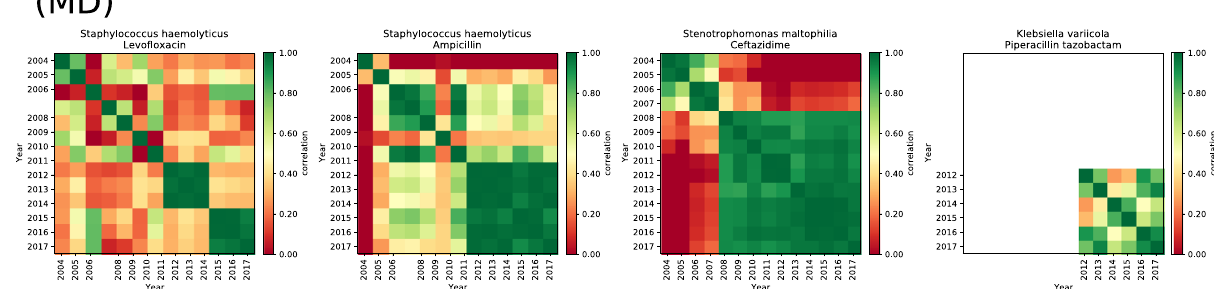
Fig. 3 Four of the “ worst ” pathogen-antibiotic (PA) pair year-year correlations ranked by τ (as de fi ned in Supplementary §5): these satisfy τ < 1/4. PA pairs typically have low values of τ because their correlelograms exhibit block structures consistent with high year-year correlations between MIC distributions that incorporate sudden changes. The particular MIC correlations shown here are for PA pairs that satisfy τ < 1/4 that are also classi fi ed as both D and M, as described in the text. An M label refers to a PA pair where sampling was very low in one particular year and pairs with high sampling variability across years are labelled with a V. Not shown here are other PA pairs with low sampling size across years (labelled as N) and ones where the discrepancy between TEST and INFORM MICs is high (labelled as D). Pairs that do not fall under any of these categories are labelled with a U and Supplementary Fig. 10 shows corelelograms for all the remaining PA pairs that satisfy τ <